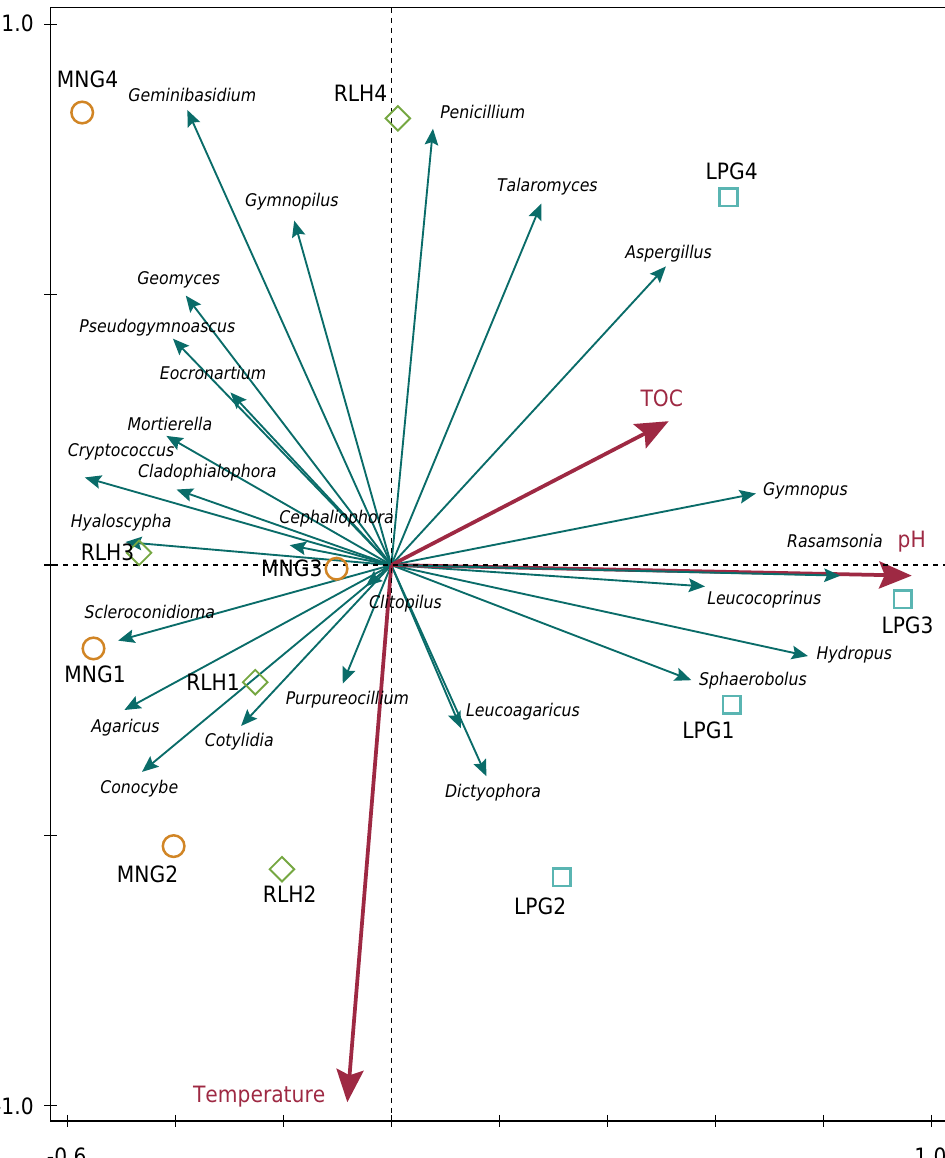
Figure 9. Redundancy analysis (RDA) of the relationship between the soil physicochemical properties and the relative abundance of fungal genus of the twelve soil samples (p<0.05). Different symbols in the graph represent soil samples from different treatments: Circle = MNG; Square = LPG; and Diamond = RLH. Arrows indicate the direction and magnitude of variables. Note: RLH: raising laying hens under forest; LPG: cultivating Lolium perenne grass under forest; MNG: maintenance of native grass under forest. The number after the treatment symbol means: 1 = spring; 2 = summer; 3 = autumn; 4 = winter. Bottle green lines represent fungal genus; red lines represent environmental